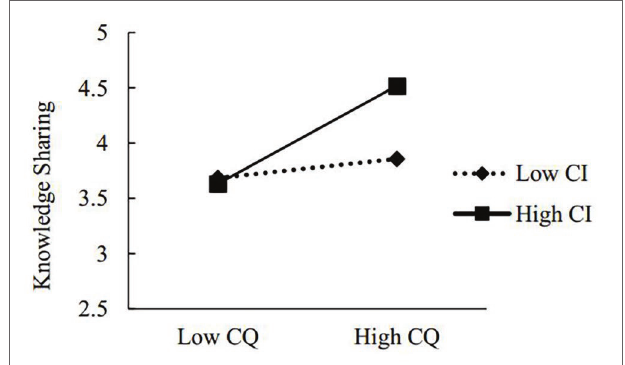
FIGURE 2 | Interactive effects of cultural intelligence (CQ) and climate for inclusion on knowledge sharing.